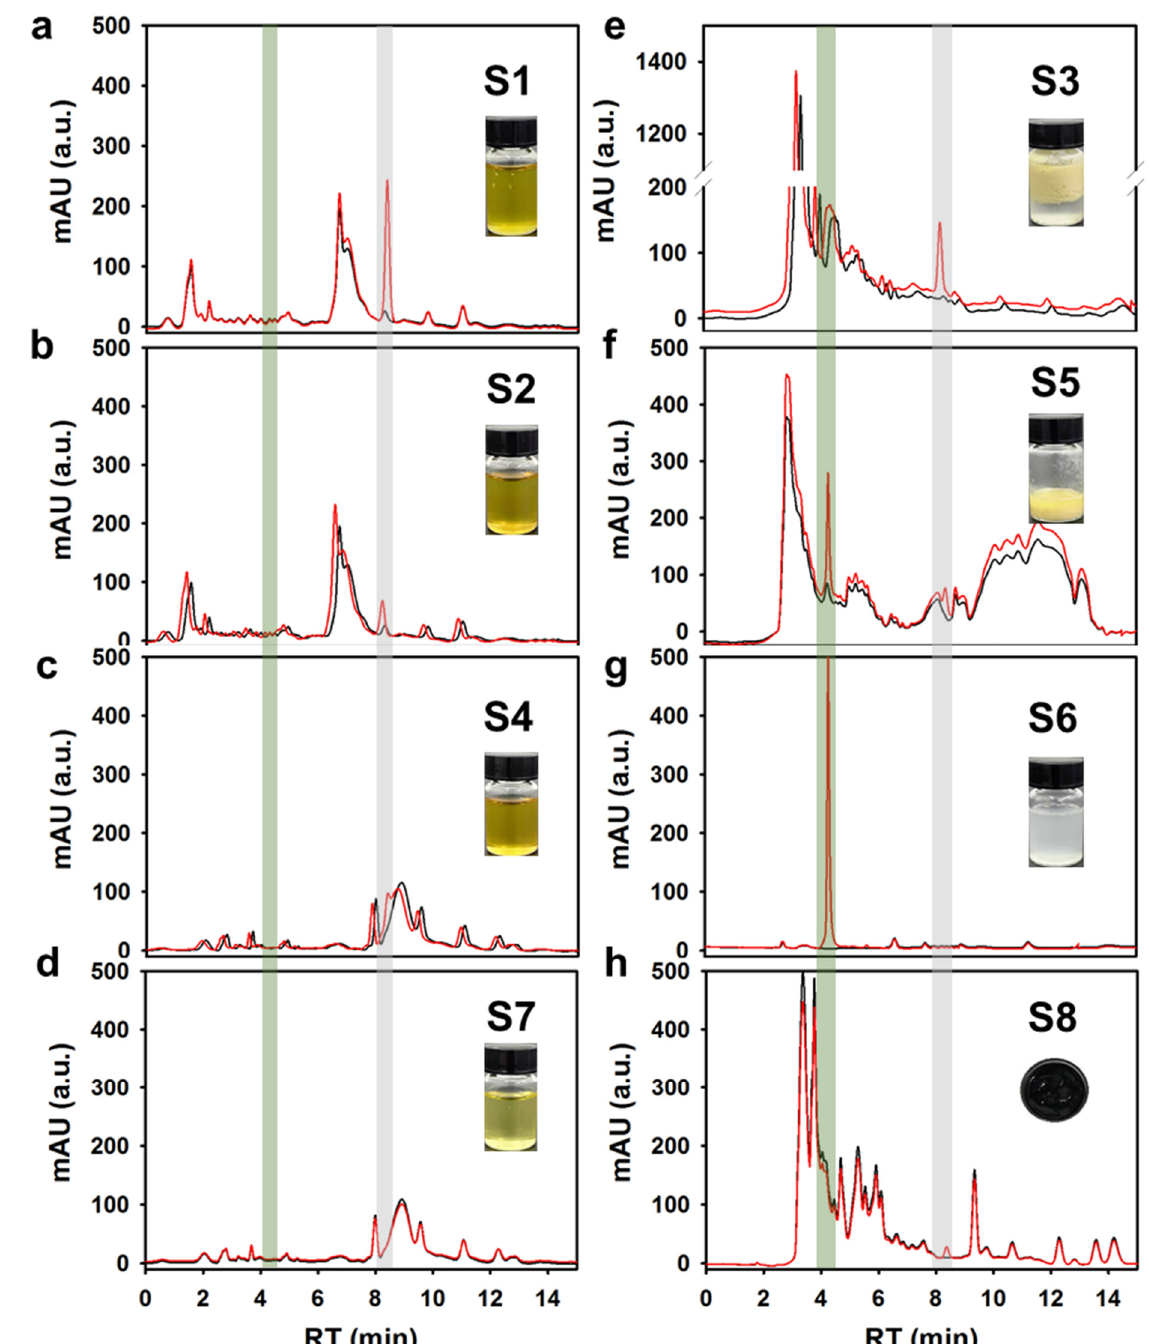
Figure 5. HPLC chromatogram spectra. The germ oil with different refined degrees and wastes were extracted by an acetonitrile aqueous solution (84%, v / v ) with (red line) or without (black line) DON, including crude oil ( a ), degummed oil ( b ), deacidified oil ( c ), decoloration oil ( d ), colloidal impurities ( e ), soap stock ( f ), wash water ( g ), and clay ( h ).